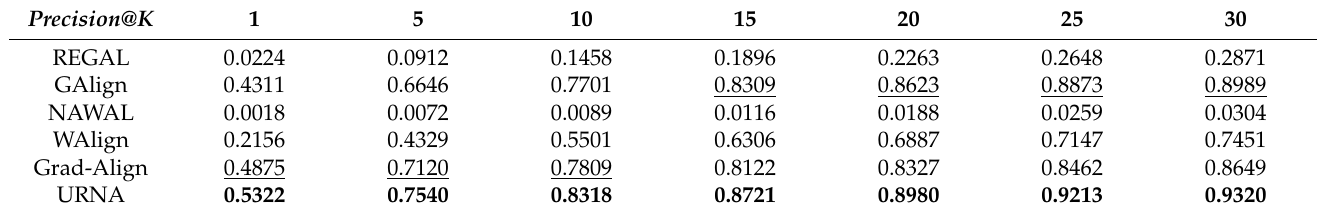
Table 3. Experimental results on Douban given different Precision @ K settings. Here, the best and second best performers are highlighted by bold and underline, respectively.